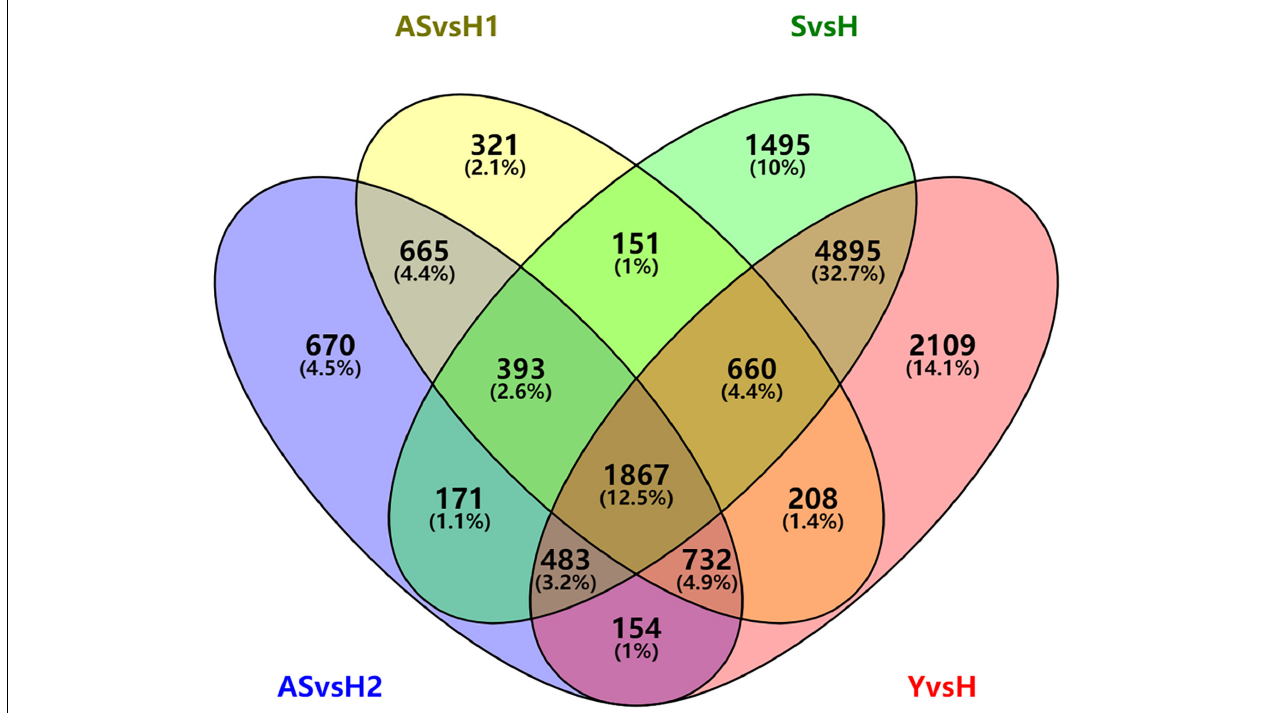
FIGURE 3 | Venn diagram of differentially expressed genes in periwinkle infected with “ Candidatus Liberibacter asiaticus.”